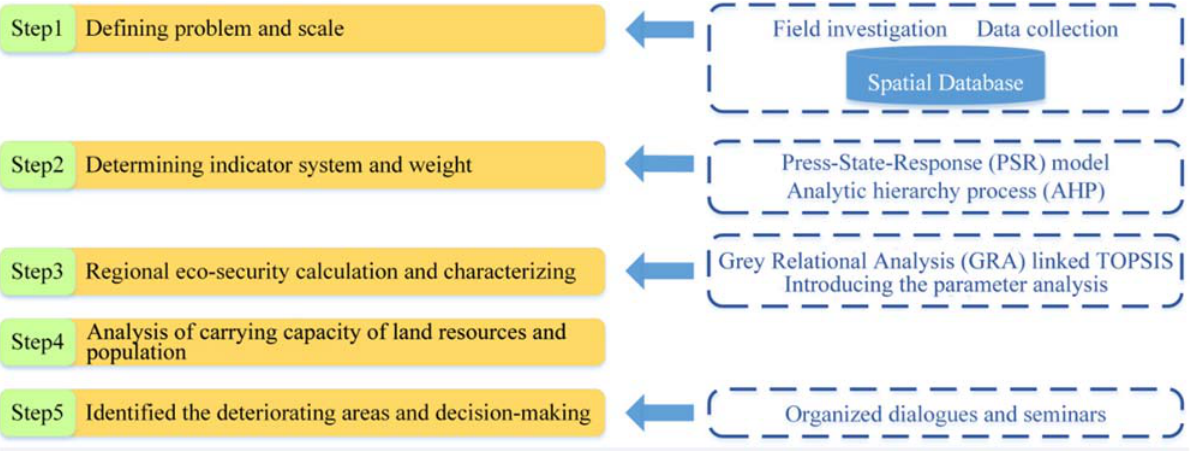
Figure 2. Procedure for regional land eco-security assessment in Daye.